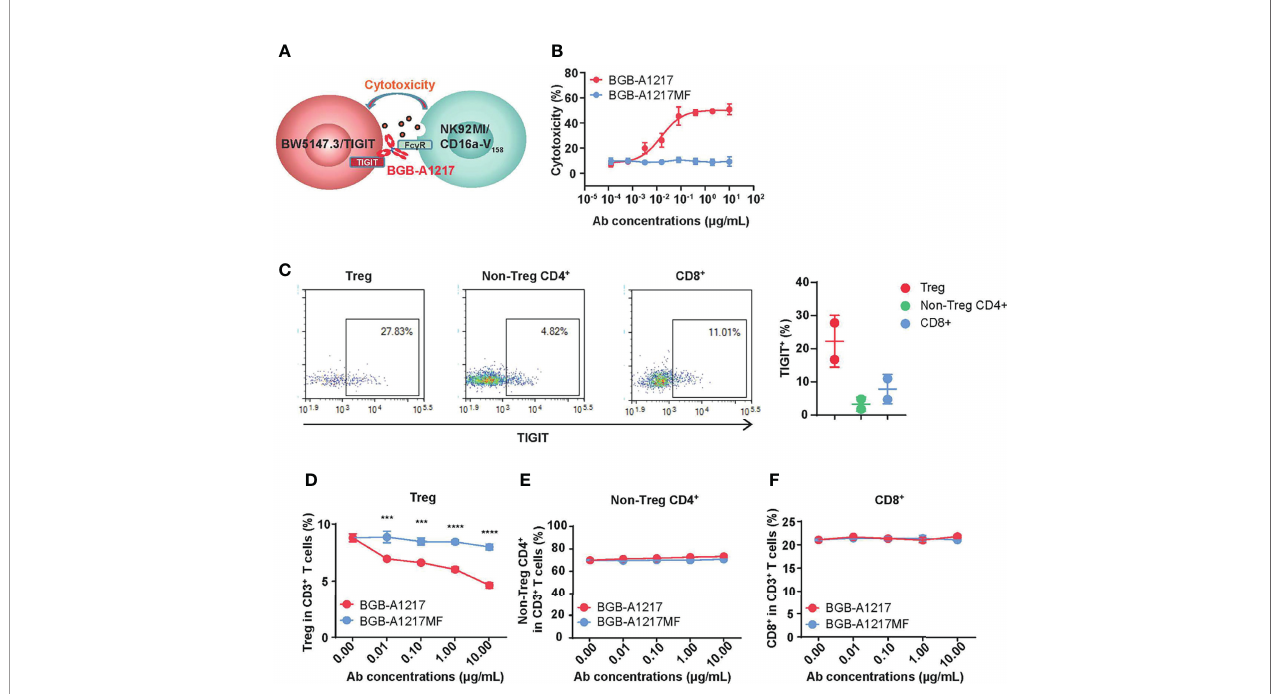
FIGURE 3 | BGB-A1217 preferentially decreases Tregs in an Fc dependent manner. (A) schematic diagram of the BW5147.3/TIGIT and NK92MI/CD16a-V 158 co- culture system. (B) Cytotoxicity against BW5147.3/TIGIT in the presence of BGB-A1217 or BGB-A1217MF. (C) Left, representative dot plots for TIGIT expression on Treg, non-Treg CD4 + T cells and CD8 + T cells from one lung cancer patient donor derived PBMCs. Right, Percentage of TIGIT + cells in CD3 + T cell subsets of PBMCs from two lung cancer patient donors. Each dot represents one donor. Data shown as mean ± SD. (D – F) the indicated anti-TIGIT antibodies BGB-A1217 or BGB-A1217MF, were incubated with human PBMC from a lung cancer donor, and NK cells from a healthy donor overnight. Cells were collected for FACS analysis. Frequencies of Treg (D) non-Treg CD4 + T cells (E) and CD8 + (F) in CD3 + T cells. Data shown as mean ± SEM. N = 3. Comparison between A1217 and A1217MF at each concentration level (D) was performed using a two-way ANOVA model with Sidak multiplicity adjustment. *** p < 0.001, **** p <